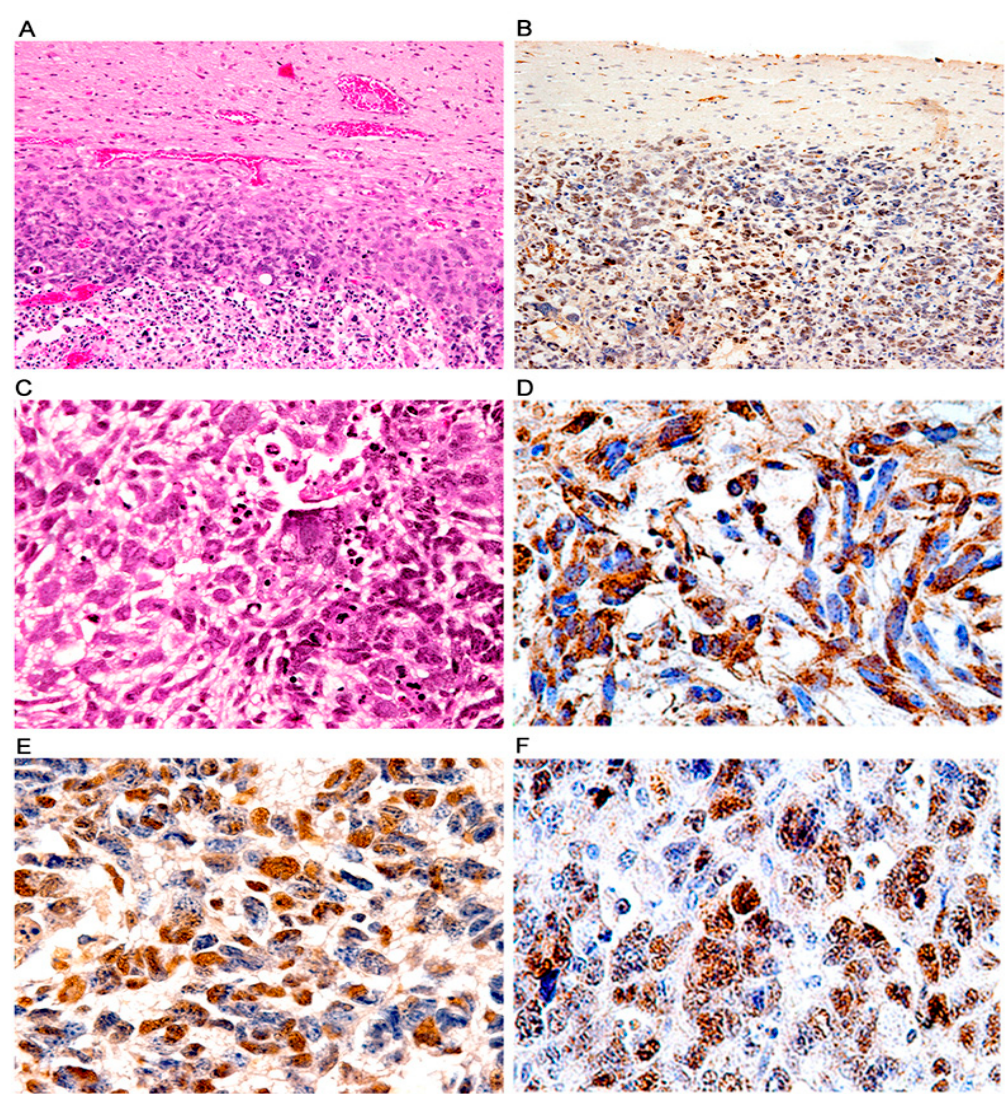
Figure 8. Glioblastomas; histological and immunohistochemical characterization. Low magnification views of glial tumors originating in the cortex of transgenic mice. These tumors exhibit prominent areas of necrosis (Panel ( A ), H&E), and T-Antigen expression (Panel ( B ), both panels original magnification 100 × ). Histologically, these aggressive tumors were composed of numerous irregular malignant cells with highly atypical and pleomorphic nuclei and abundant cytoplasm. Numerous giant multinucleated cells, mitotic figures and areas of necrosis are observed (Panel ( C ), hematoxylin and eosin). Robust cytoplasmic immunoreactivity for GFAP is present in practically all neoplastic cells confirming the astrocytic phenotype (Panel ( D )). Expression of T-Antigen (Panel ( E )) and p53 is found in the nuclei of neoplastic astrocytes (Panel ( F )). (Panels ( C )–( F ) original magnification ×400).